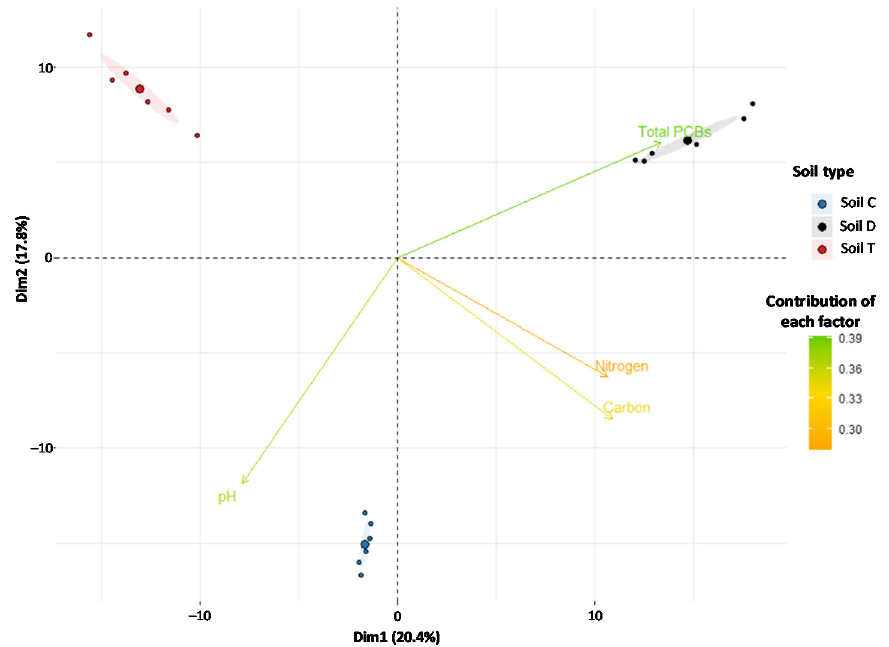
Figure 2. Principal component analysis (PCA) of fungal communities in the studied soils. The analyses were based on the sequences of OTUs present in the three soils taking into account the concentrations of the 7 indicator PCBs as well as the soil physico-chemical factors. The blue, black and red dots correspond respectively to the fungal communities of soils C, D and T. Ellipses represent 95% normal probability.